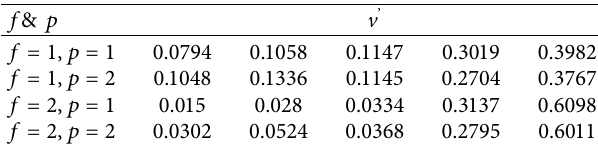
Table 3: The synthetic parameters of surround rock quality.